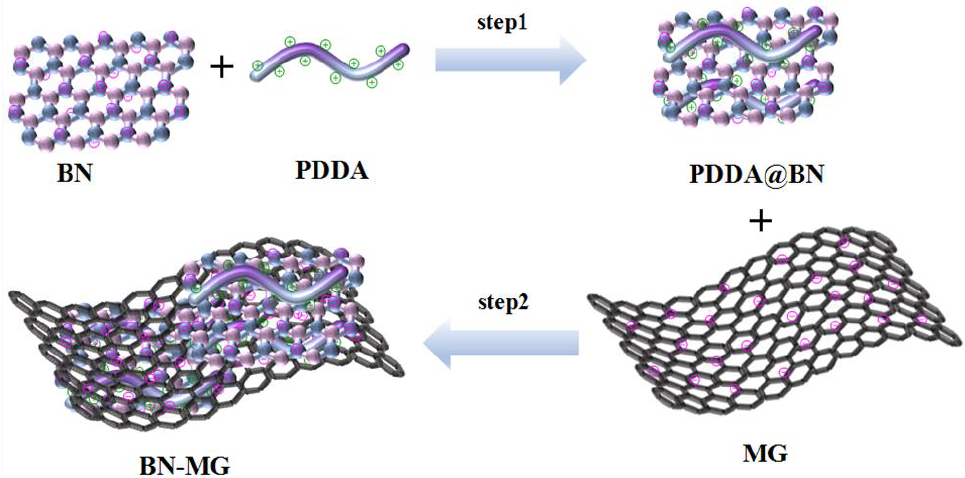
Figure 1. The schematic of the preparation route of BN − MG.